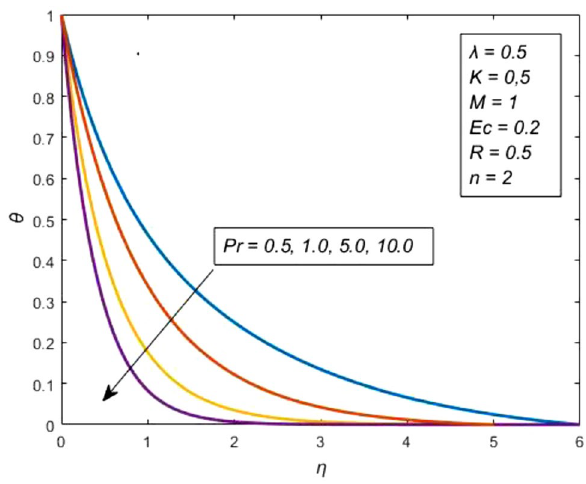
Figure 9. Temperature profile for various values of Prandtl number Pr